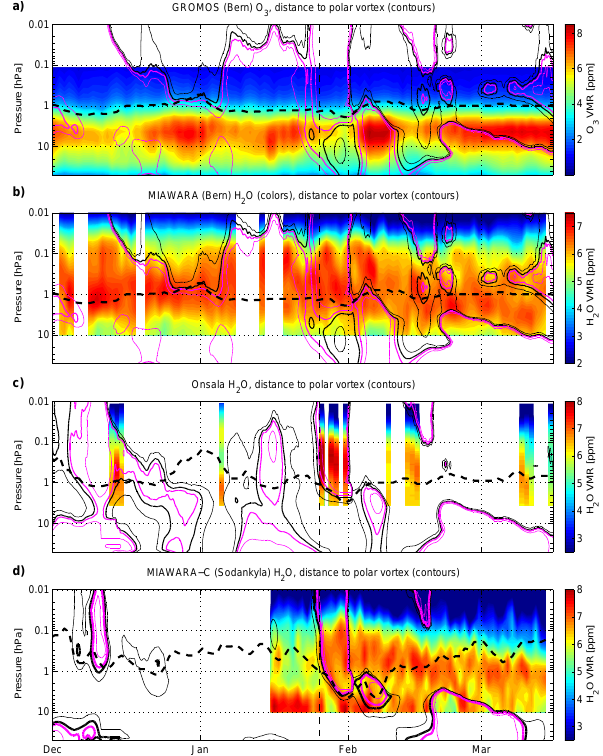
Fig. 6. Ground-based radiometer measurements of O 3 and H 2 O during winter 2009/2010. (a) GROMOS O 3 VMR in Bern. (b) MIAWARA H 2 O VMR in Bern. (c) H 2 O VMR in Onsala. (d) MIAWARA-C H 2 O VMR in Sodankyl¨a. Units are ppm. Red (blue) colors correspond to relatively high (low) values. The contour lines indicate when the polar vortex crossed the measurement location (see text for details). The vertical black dashed line indicates the beginning of the major SSW in the stratosphere. The thick dashed black line indicates the stratopause (obtained from the temperature maximum in Aura MLS temperature